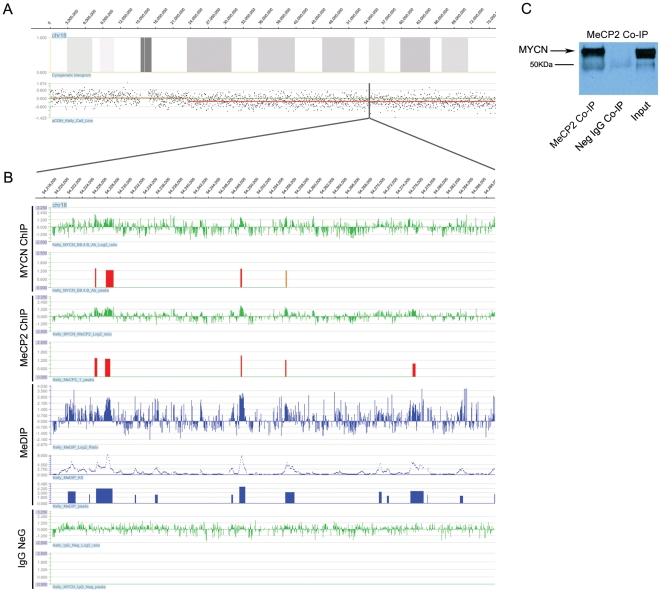
Analysis of MYCN, MeCP2 and hypermethylation in a region of hemizygous deletion.(A) Array CGH analysis of the Kelly cell line showing a large 52.6MB terminal deletion on the long-arm of chromosome 18. (B) A tiled 70.5-kb section of the hemizygously deleted region on chromosome 18, the upper panels display the raw log2 ratios and the identified, consistent binding sites for both MYCN and MeCP2. Peaks displayed are considered high confidence binding sites with an FDR score of <0.05 (red peaks) and 0.05-0.1 (orange peaks). Kelly MeDIP results are represented by the panels in blue, including the raw log2 ratios, Kolomogorov-Smirnov test p-values (−log10), and the identified peaks of hypermethylation. The lower panels show the results of a negative control experiment using normal mouse IgG. (C) A western blot of a Co-IP performed using anti-MeCP2 antibody.